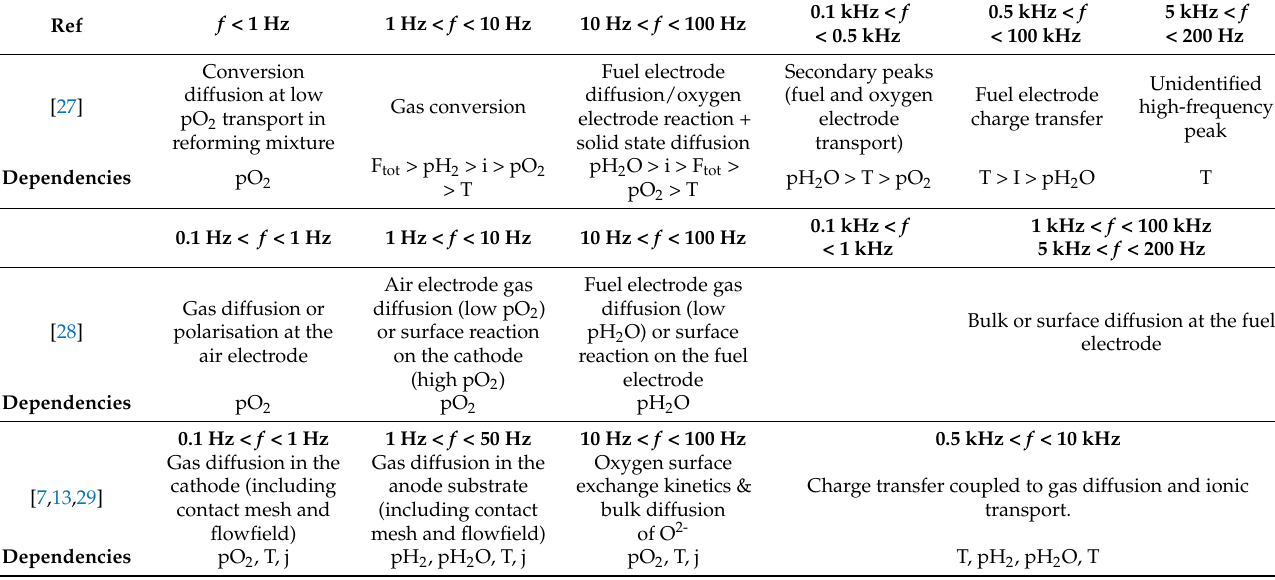
Table 1. Literature survey of possible peak